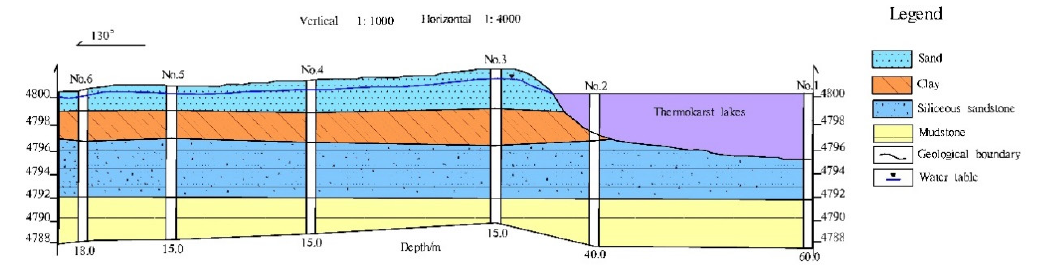
Figure 3. Hydrogeological cross section.